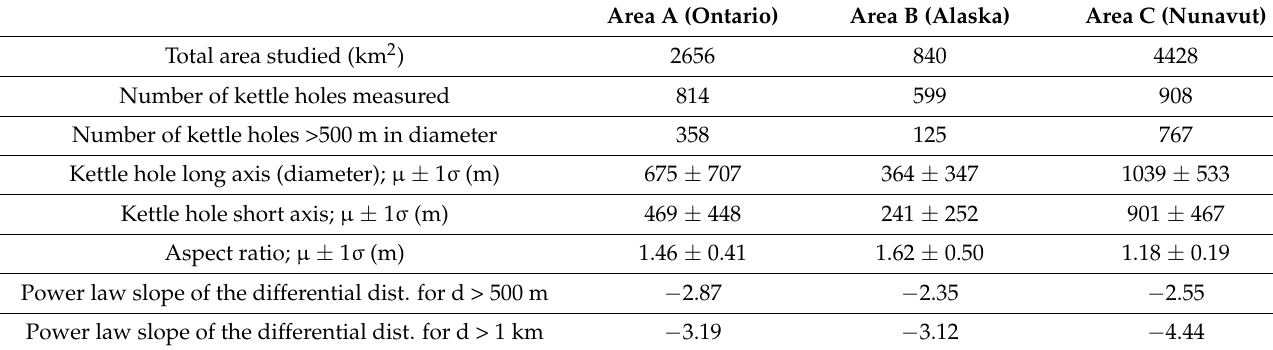
Table 1. Kettle hole summary